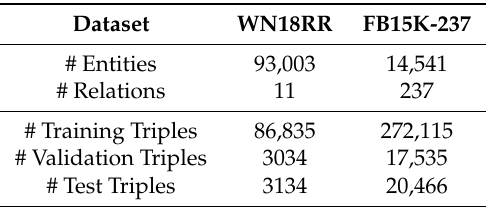
Table 1. Simple statistics on data